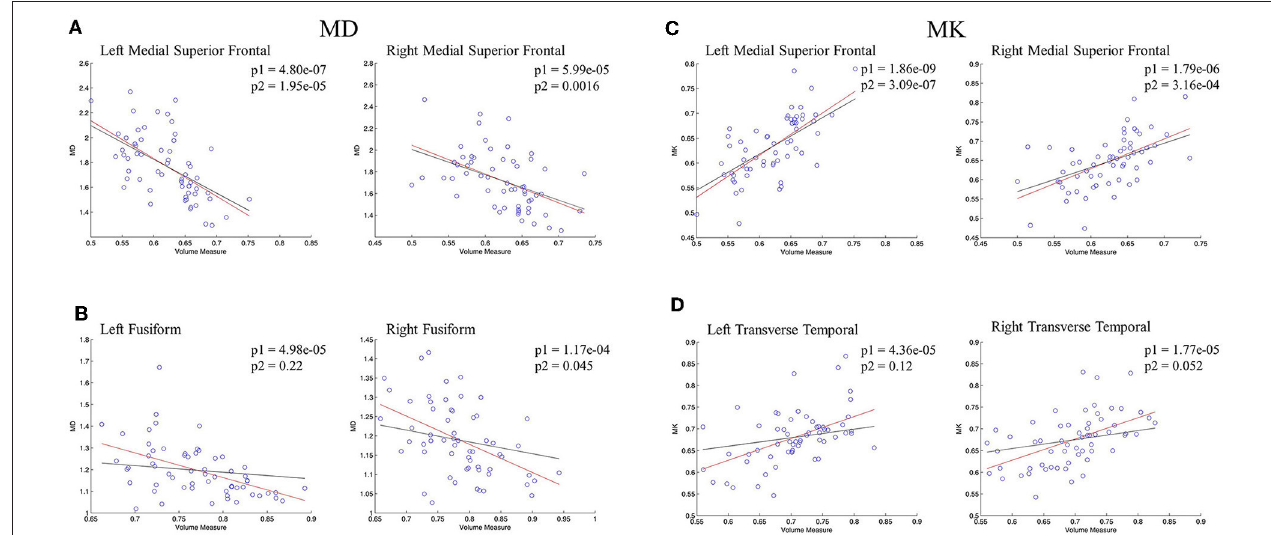
FIGURE 5 | The regression results of GM volume and DKI indexes in representative regions. (A,B) showed the scatterplots of GM volume and MD; (C,D) showed the scatterplots of GM volume and MK. The red lines represent a linear regression between GM volume and microstructure indexes, and the black lines represents a linear regression between GM volume and microstructure indexes after controlling for age. The significant levels of red lines and black lines were p1 and p2,